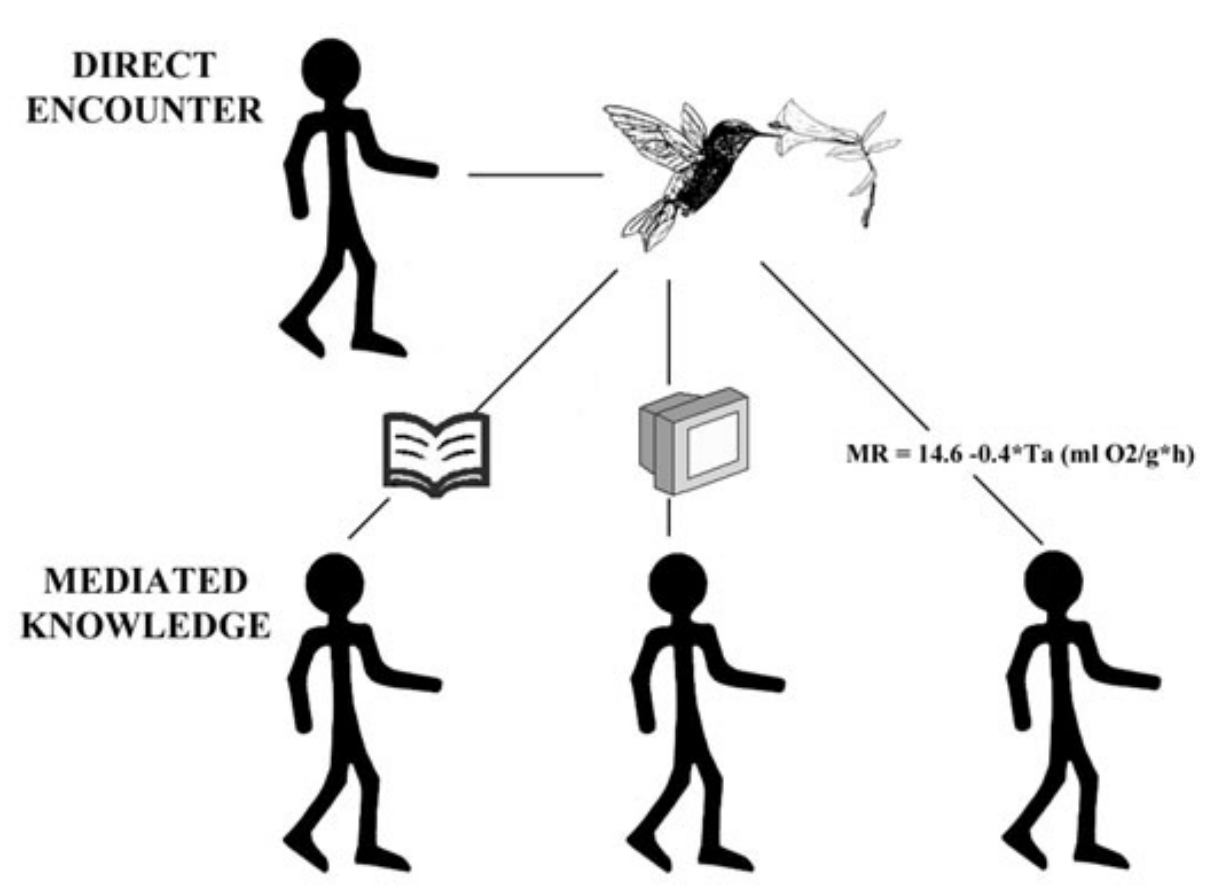
Fig. 6. Omora initiative emphasizes field experiences and direct or immediate encounter with other living beings. Through this educational approach, Omora Park counterbalances the excess of “mediated information,” which prevails in formal and informal education. Presently, most of our knowledge about nature is mediated through established scientific narratives, e.g., Darwin’s Voyage of the Beagle, through technological media such as TV or computers, e.g., videotape of the firecrown hummingbird visiting Philesia magellanica flowers, and/or by mathematical models and equations, e.g., the hummingbird Omora is studied through an equation for metabolic rate of Sephanoides sephaniodes. Equation taken from López-Callejas and Bozinovic